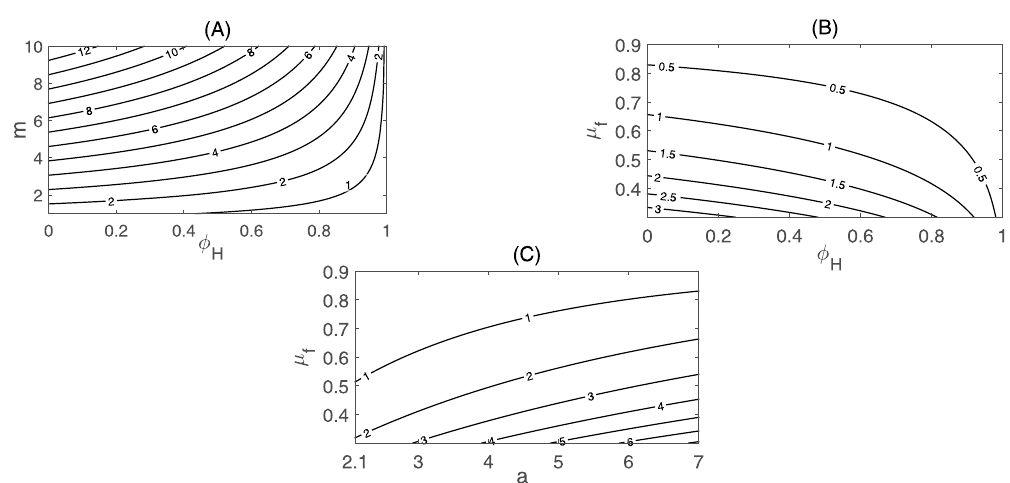
Figure 9. Contour plots of R 0 . Plot contours of R 0 versus the proportion of person precaution φ H and ( A ) the density of female mosquitoes per person m ; ( B ) the death rate of adult Wolbachia-free mosquitos μ f ; ( C ) Plot contours of R 0 versus α and μ f . All other parameters values are as shown in Table